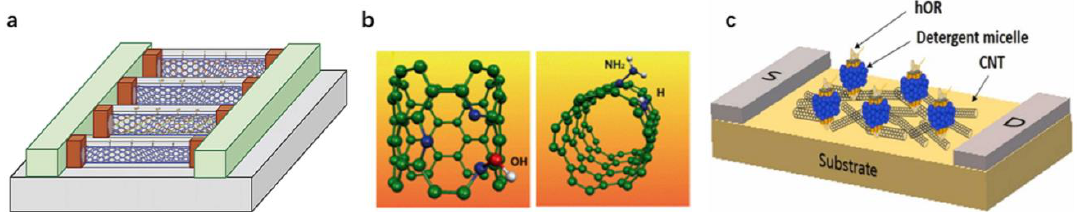
by permission of the American Chemical Society.; ( b ) Molecular model of the carbon nanotube, whose surface is doped with OH group (red) and NH 2 group (blue) with pyridine site. Reproduced from Villalpando — Páez et al. [190] by permission of Elsevier Science Ltd.; ( c ) Schemata of the hOR-based CNT-FET sensors for the DMMP detection. Reproduced from Jin et al. [176] by permission of Elsevier Science Ltd.